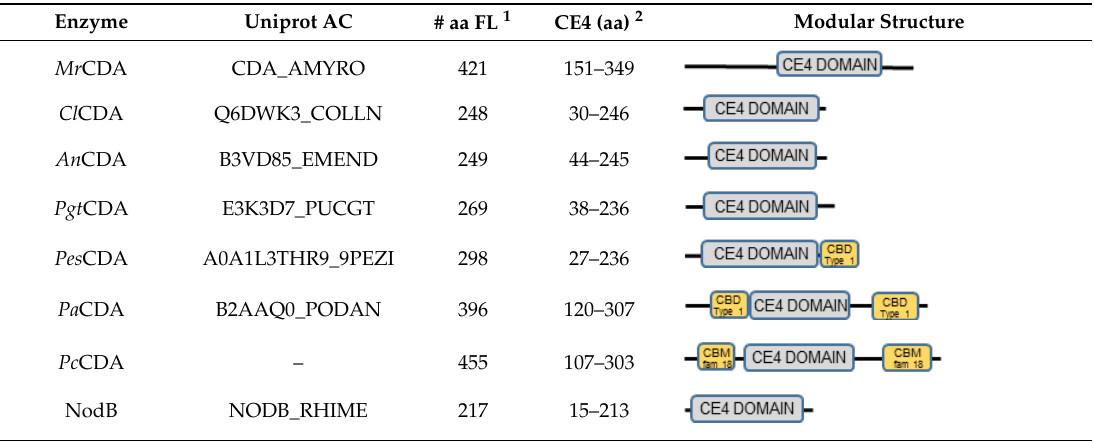
Table 2. Modular organization of domains in CE4 enzymes. Modular structures were defined using the Interpro database tools [149].